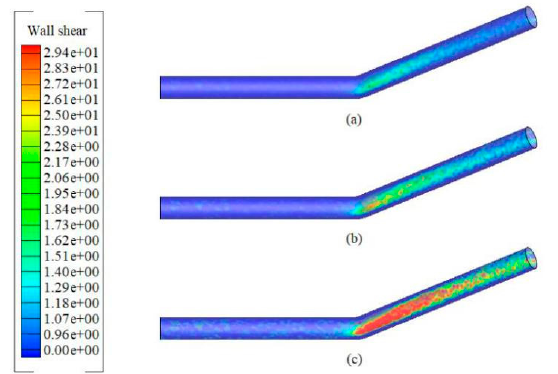
Figure 8. Contours of the wall shear stress in an upward-inclined pipe (30°) with a gas superficial velocity of 5 m/s at different water contents, where ( a ) 10% water–90% gas, ( b ) 30% water–70% gas, and ( c ) 50% water–50% gas.